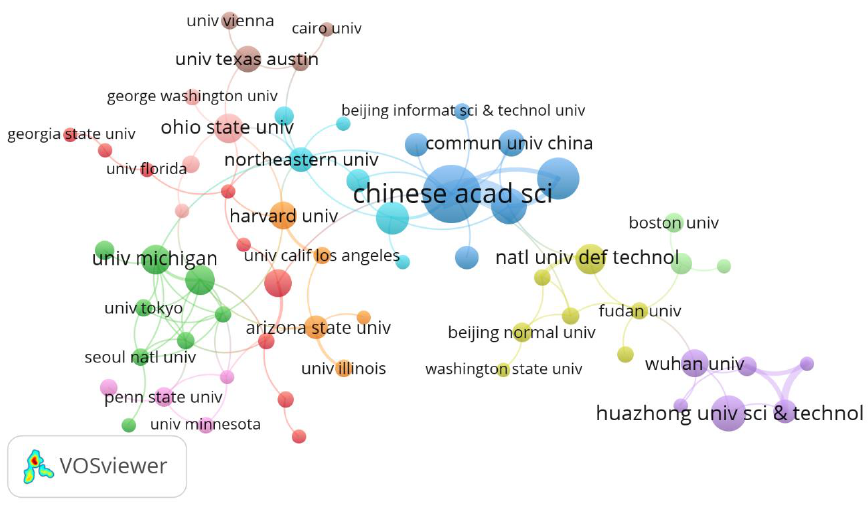
Figure 6. Cooperation institutions in NPO studies, 1990 – 2020.